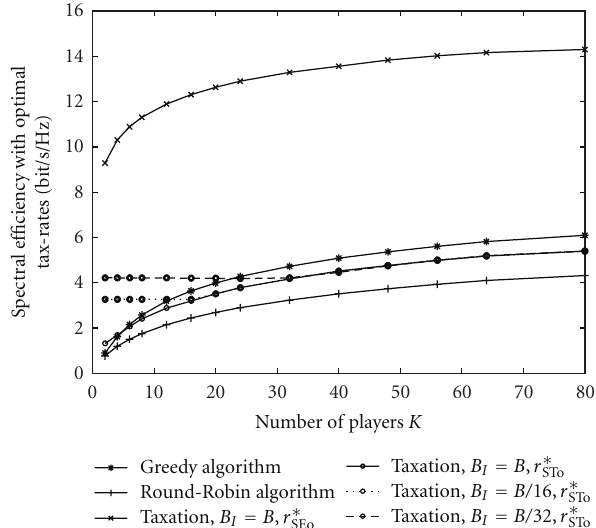
Figure 10: Spectral e ffi ciency for the optimal tax rate for both SelBM and SocBM; two-path channel model.